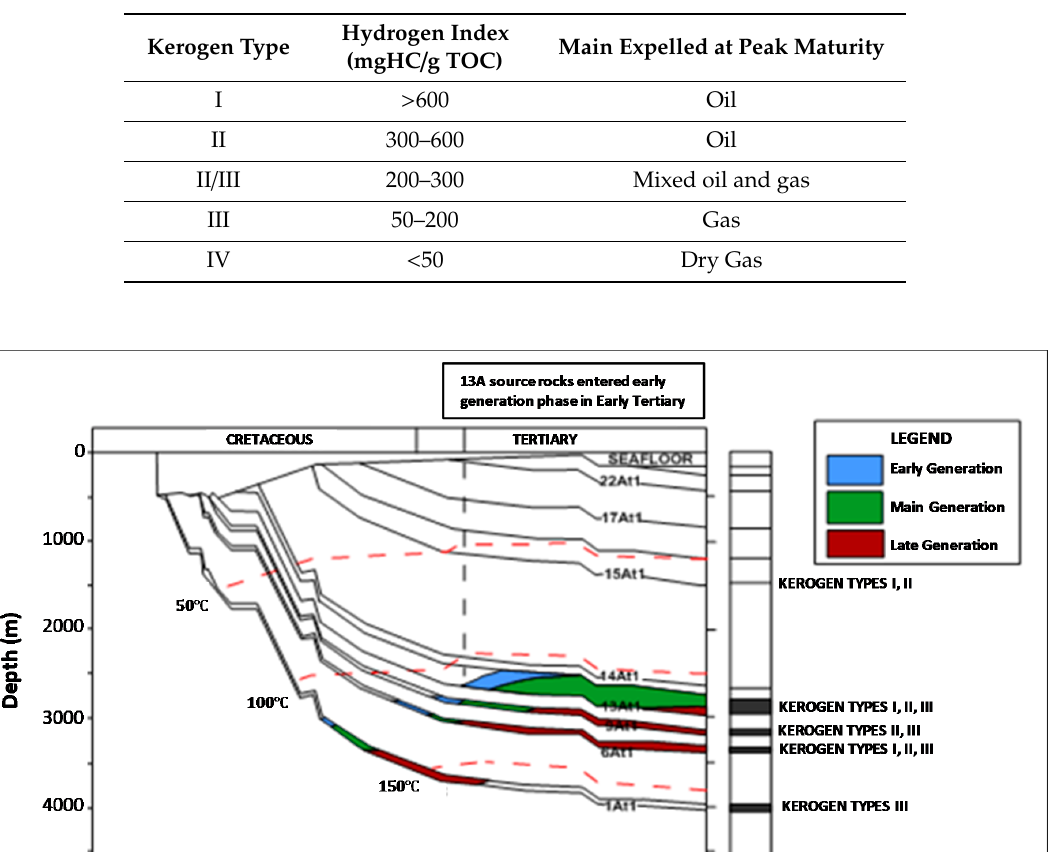
Table 2. Geochemical parameters for describing the kerogen type and hydrocarbon type generated [16].